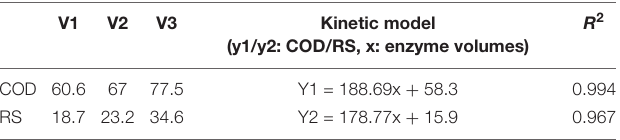
TABLE 2 | Relationship between enzyme volumes and COD/RS in the LCR hydrolyzate.